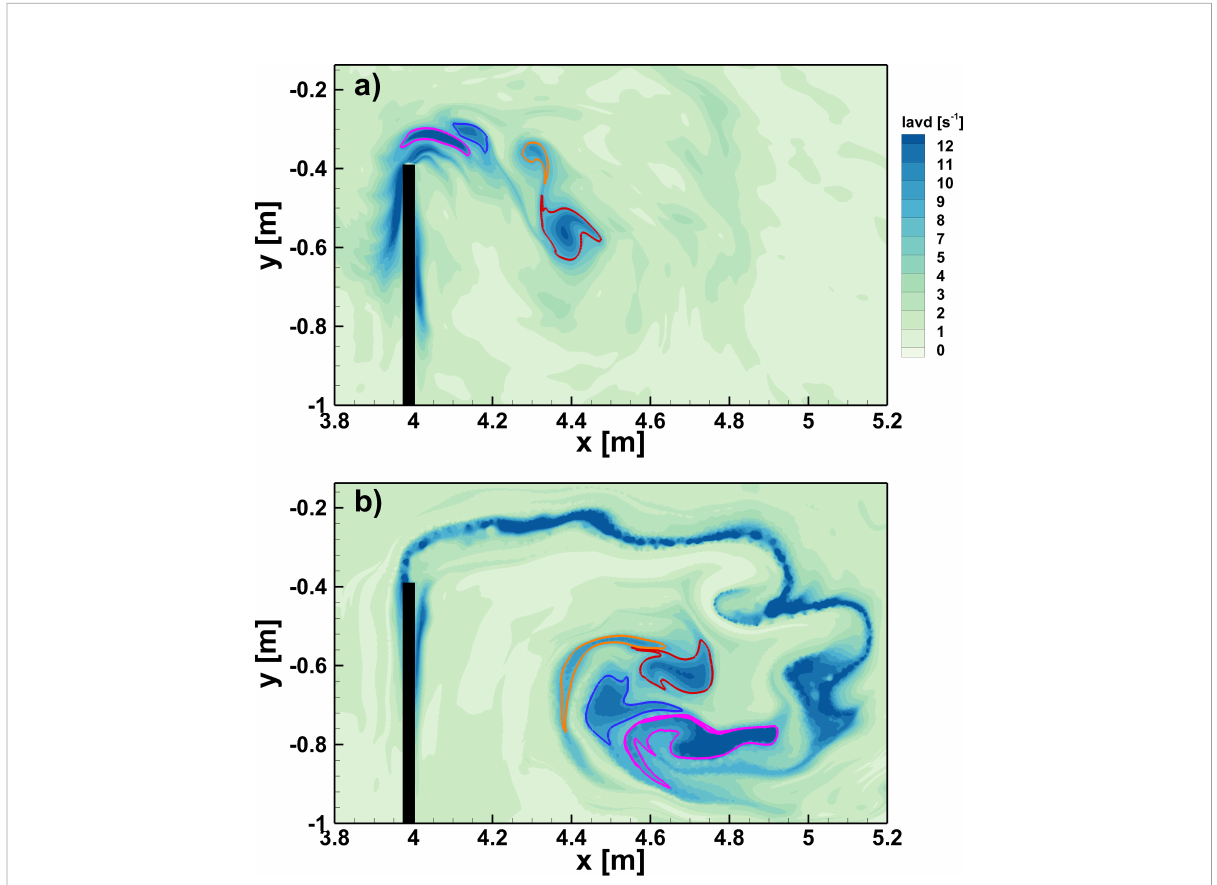
FIGURE 9 Vortex interaction identi fi ed through LAVD. Panel (A) shows LAVD computed in fl ood phase with vortices identi fi ed with closed contour. Panel (B) shows advection of LAVD alongside with the particles that constitute the vortex boundary. Typical fi lamentation in vortex advection is visible. However, vorticity coherence is maintained inside vortex boundaries. A trail of strong vorticity is depicted in Panel (B) , too. Detachment of boundary layer with vortex formation is clearly visible together with the most probable path